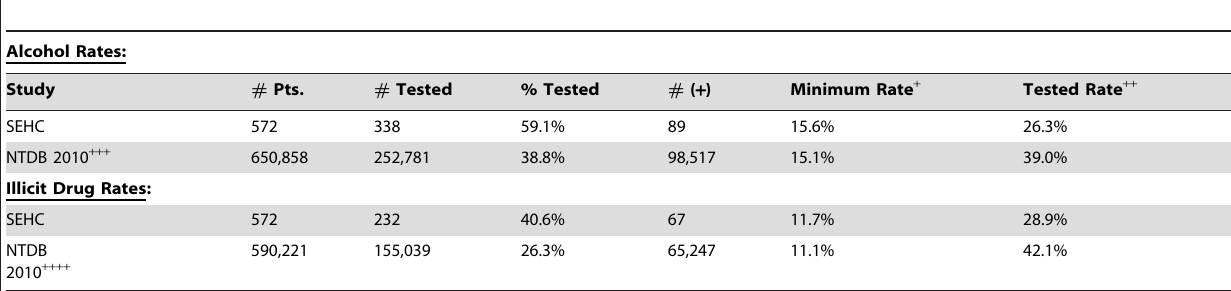
Table 5. Comparison of SEHC Trauma Center Admissions with NTDB Trauma Center Admissions, alcohol and illicit drug rates.